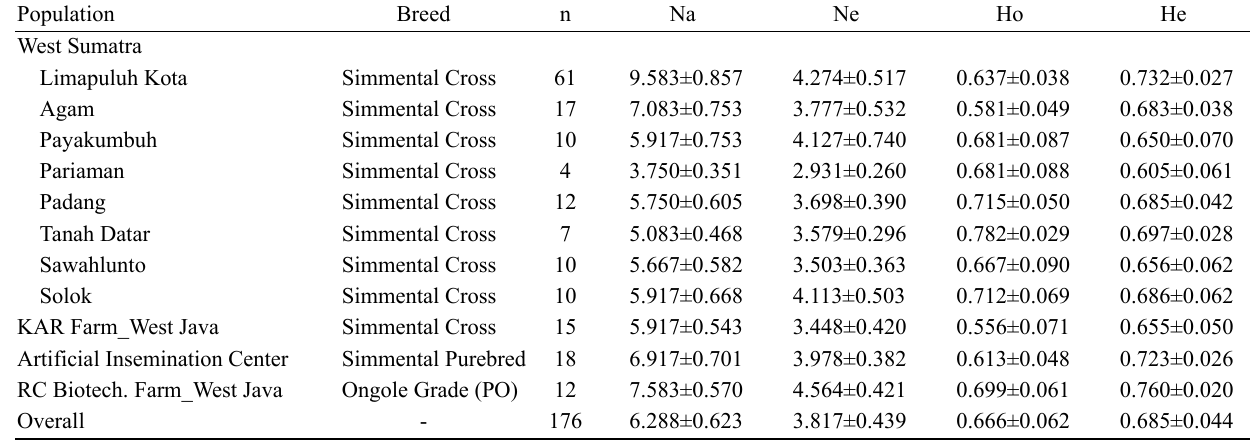
Table 2. Summary statistic of the mean number of observed allele (Na), mean number of effective alleles (Ne), observed (Ho)